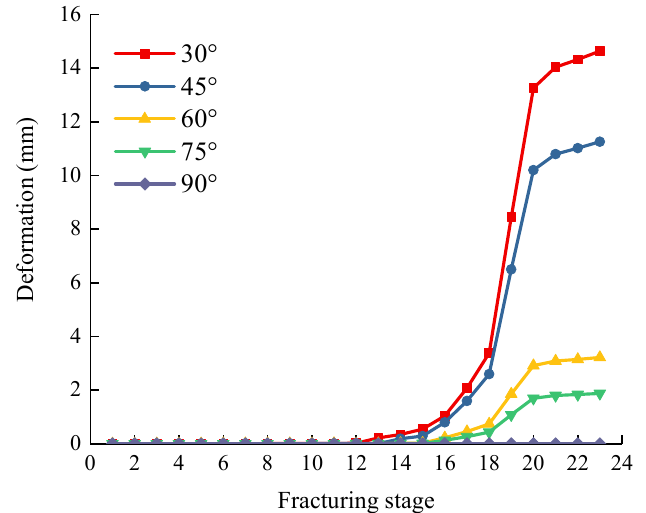
Figure 16. Influence of fault inclination angle on casing deformation.